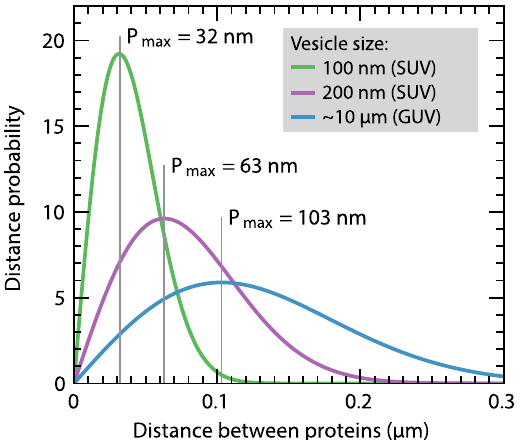
Figure 7. Calculated distance distribution of proteins in vesicles. Distance-probability distribution between cyt. bo 3 and ATP-synthase for the protein concentration in the ~10 μ m GUVs (30 proteins/ μ m 2 ) as well as for the 200 nm (80 proteins/ μ m 2 ) and 100 nm (320 proteins/ μ m 2 ) large unilamellar vesicles. The distance of highest probability ( P max ) is indicated in the figure. The probability distribution was obtained by calculating (see e.g. ref. 52) the probability of finding the nearest-neighbor to a particle in two dimensions for distances 0–300